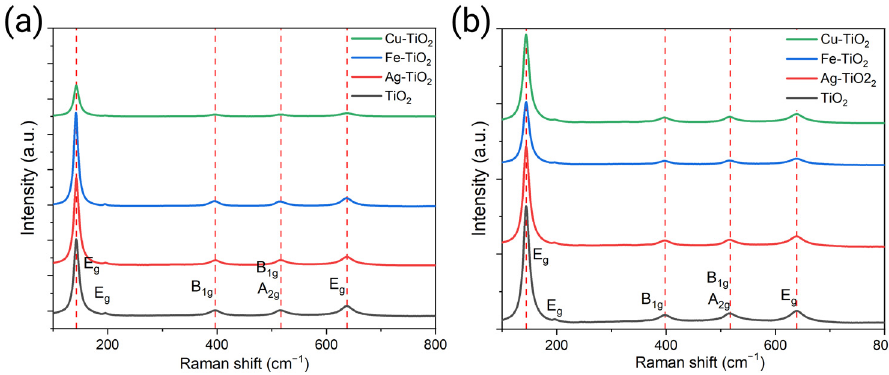
Figure 4. Raman spectra of ( a ) SG-synthesized and ( b ) Mw-SG-synthesized materials.